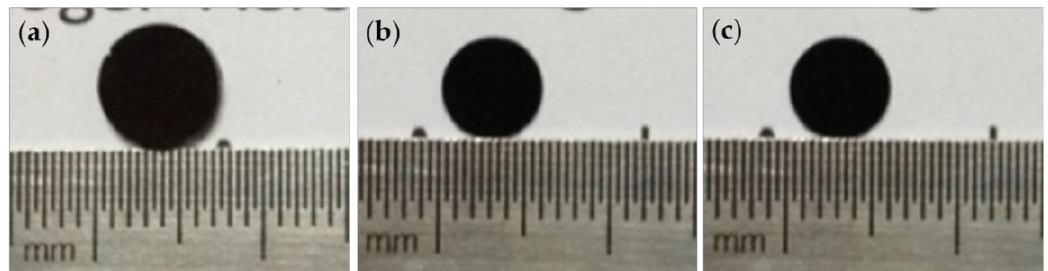
Figure 1. Appearances of samples of ( a ) RF / TiO 2 aerogel, ( b ) C / TiO 2 aerogel and ( c ) TiC / C composite